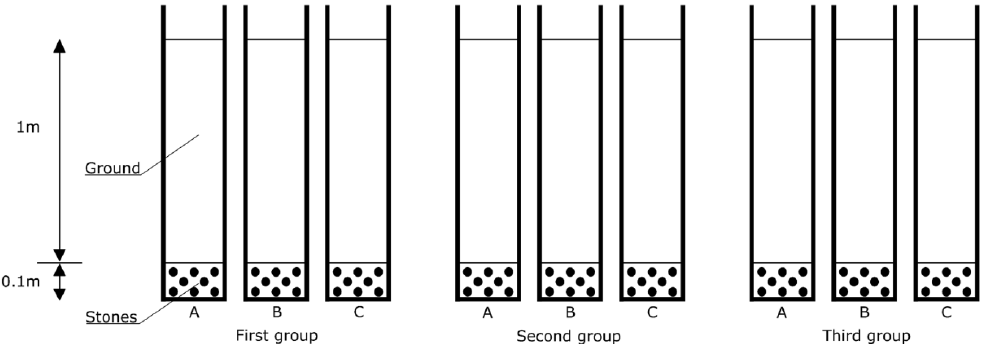
Figure 4. Diagram of the filter column arrangement used in the study of the effect of brine on the hydraulic conductivity of the soil, at a semi-technical scale; first column group — treated wastewater, second column group — treated wastewater + brine, third column group — water (A, B, C repetitions for a specific group).